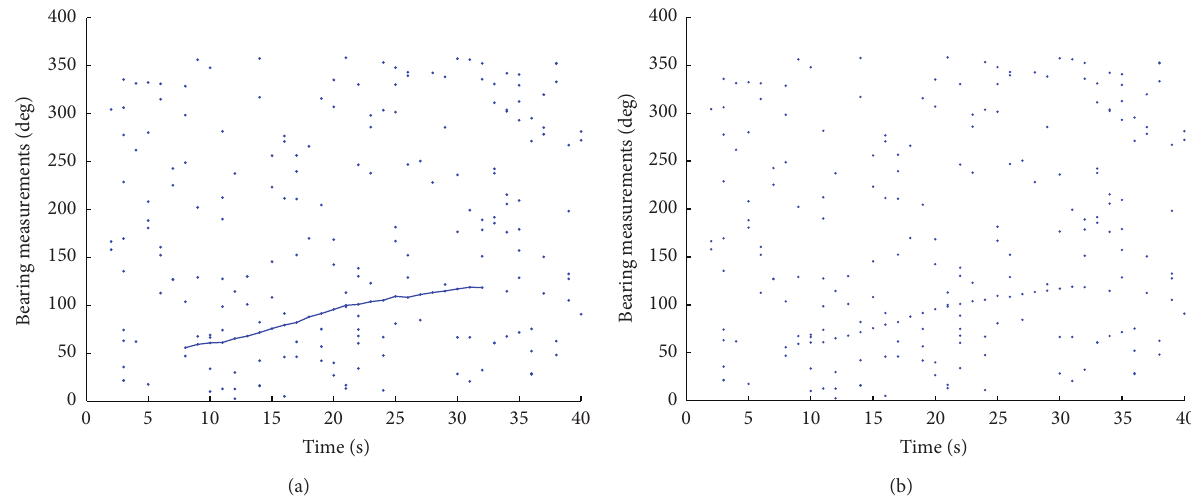
Figure 1: Received BOT measurements versus discrete time index. The left plot indicates target originated measurements by crossing them by a line, while the right plot does not give any indication on the source of each measurement.